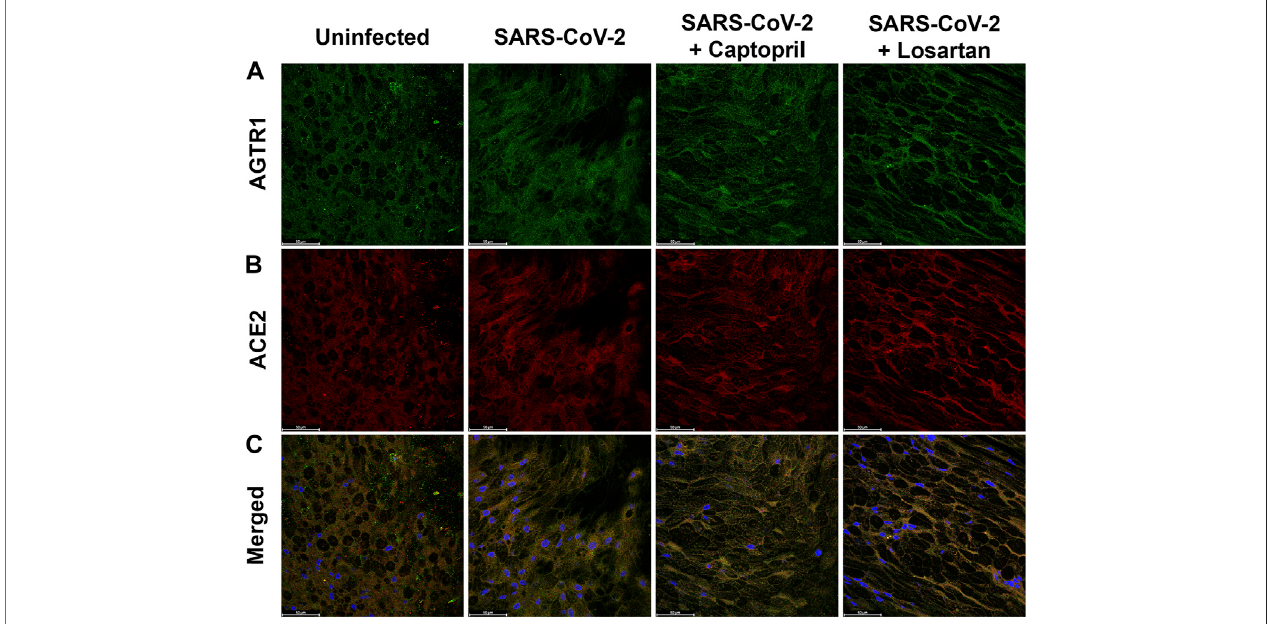
FIGURE 7 | Immuno fl uorescence staining for ATR1 and ACE2 in primary differentiated airway epithelial cell cultures infected with SARS-CoV2 and treated with either captopril or losartan. Cultures were infected with SARS-CoV-2 for 96 h and a subset were treated with captopril (1 µM) or losartan (2 µM) throughout the 96-h infection. Depicted are representative confocal images obtained through the apical plane of differentiated airway epithelial cultures; ATR1 staining is shown in green (A) , ACE2 staining is shown in red (B) , and merged images including DAPI staining (blue) are shown in the (C) . No signi fi cant differences in staining pattern were observed between the groups (63x objective; Scale bars (cid:1) 50